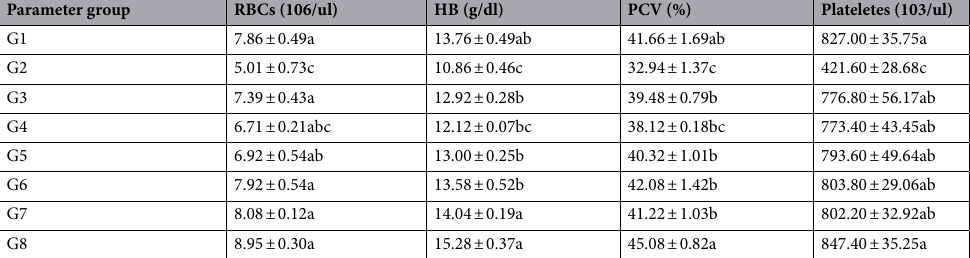
Parameter group